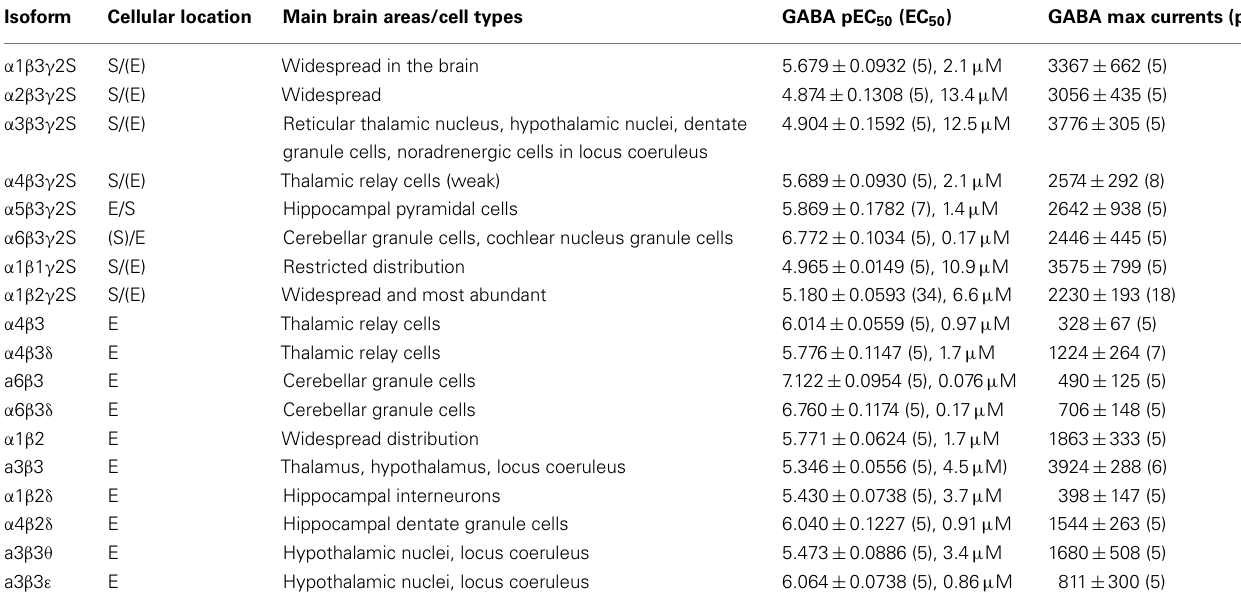
GABA potency data for isoforms of the GABA A receptor representing the most likely subtypes found in the CNS. Their putative cellular locations are indicated (S, synaptic, or E, extrasynaptic; and when this is noted in parentheses, the location and/or distribution is assumed based on the available literature). GABA potency is represented as a pEC 50 (mean ± SEM) and the number of experiments (n) is shown in parentheses. For easier interpretation, mean pEC 50 values are also transformed into EC 50 values. Mean maximum currents are provided as mean ±